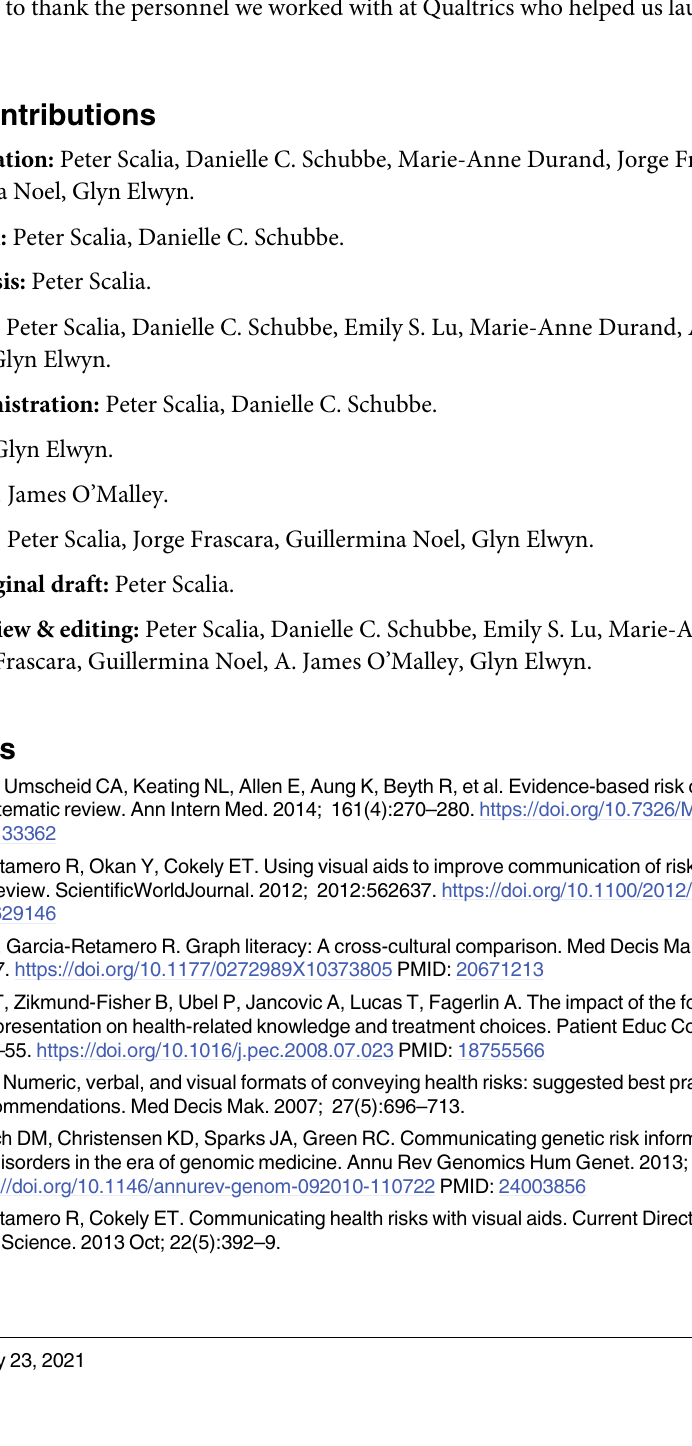
S3 Table. The participant survey. S4 Table. Logistic regression analysis to address the first study aim. S5 Table. Logistic regression analysis to address the second study aim.